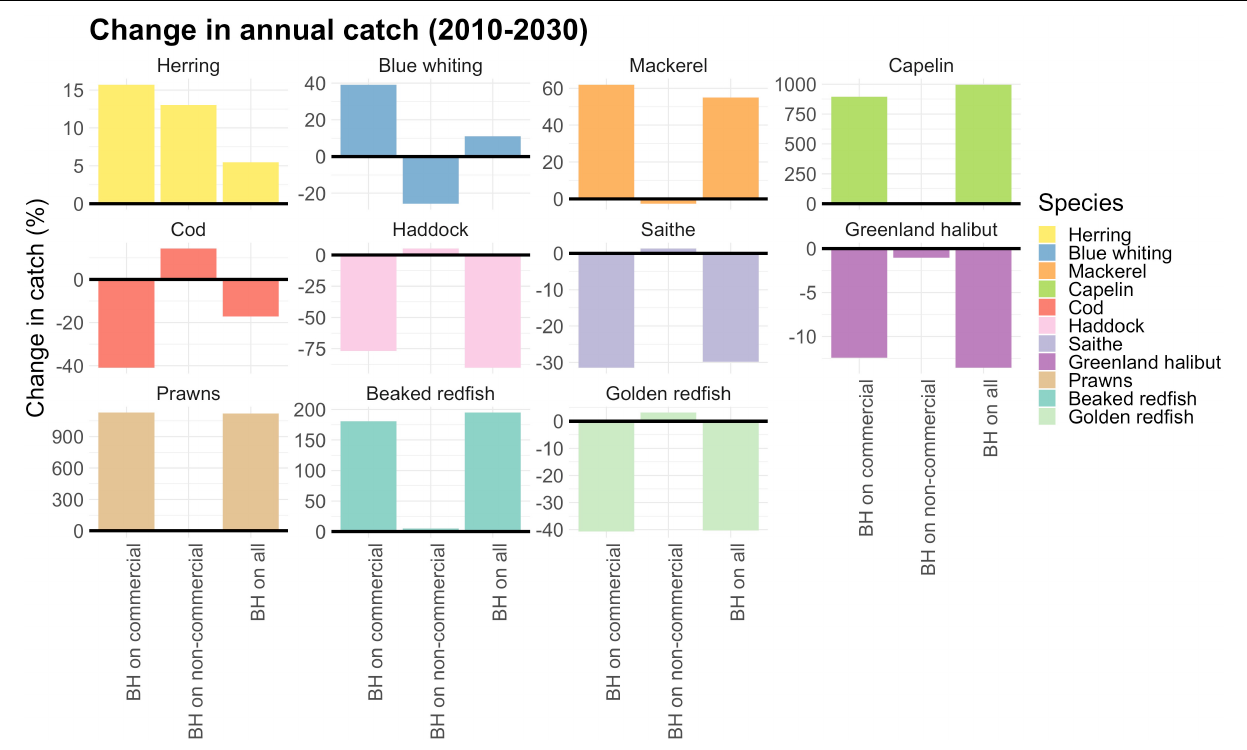
FIGURE 7 | Relative change in total catch of commercial species over the last 20 years of the simulations compared to the control run. Note the different scales of the y-axis.